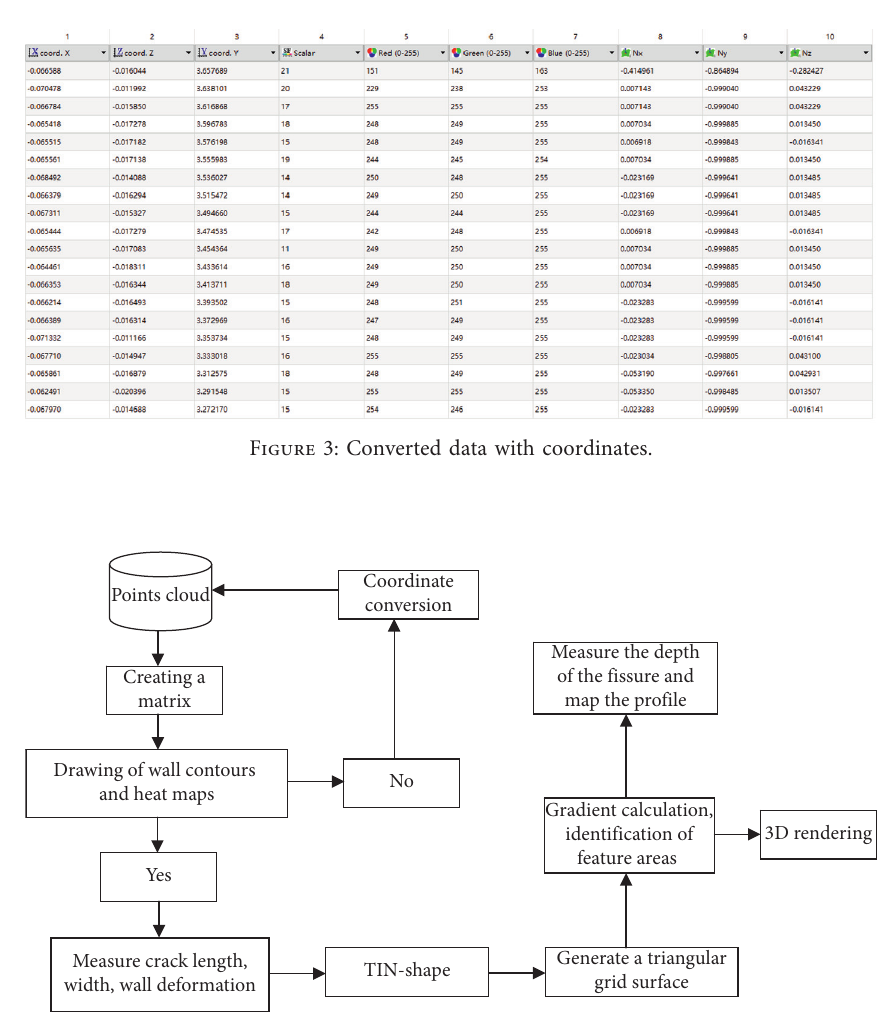
Figure 4: Analytical model workflow